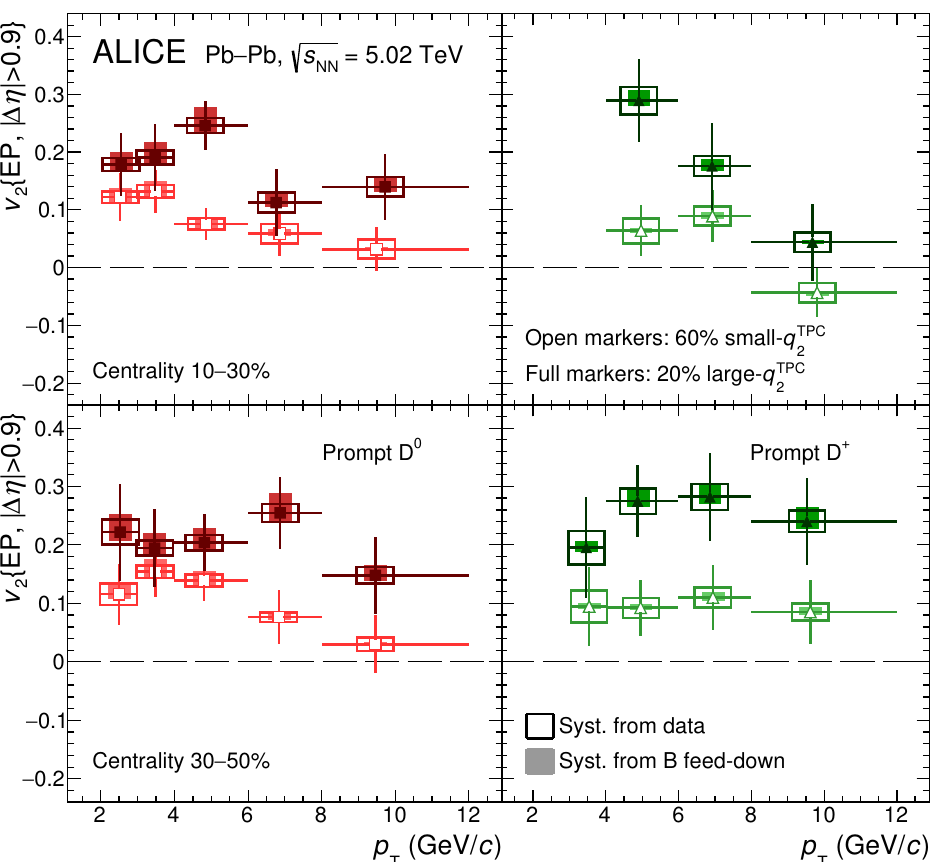
Figure 7 . D 0 (left column) and D + (right column) v 2 as a function of p T for the small- q TPC large- q TPC samples (see text for details), in Pb-Pb collisions at 2 row) and 30{50% (bottom row) centrality classes. The symbols are positioned horizontally at the average p T of the reconstructed D mesons. Vertical error bars represent the statistical uncertainty, empty boxes the systematic uncertainty associated with the D-meson anisotropy measurement and the event-plane resolution. Shaded boxes show the uncertainty due to feed-down from beauty- hadron